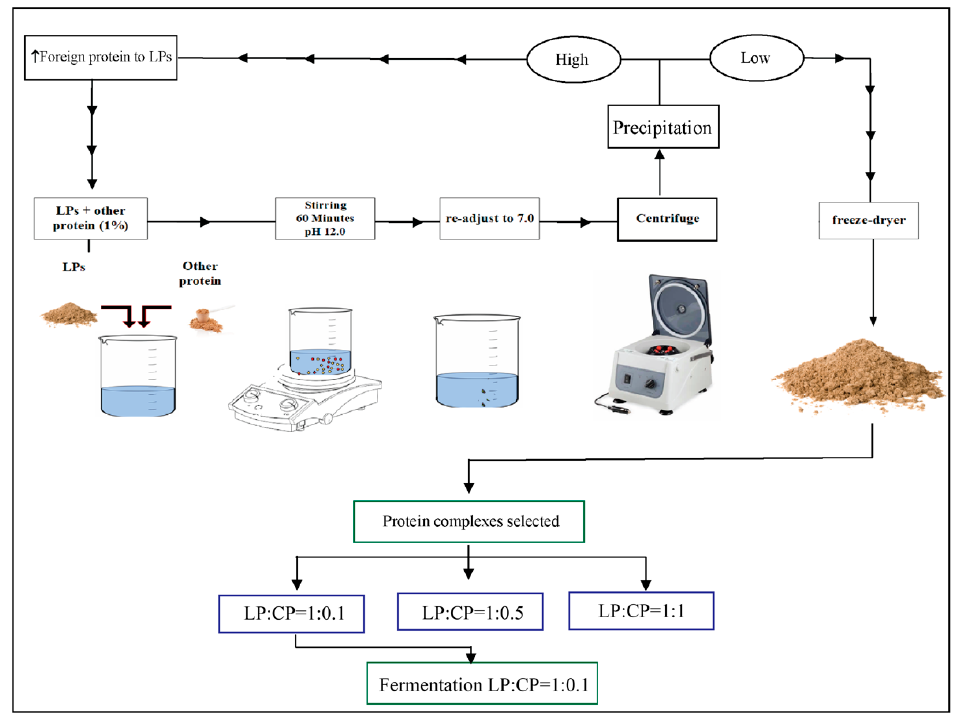
Figure 1. Schematic diagram of evaluation of fermentation treatment of lentil–casein protein com- plexes (LCPC) generated by structural interactions.